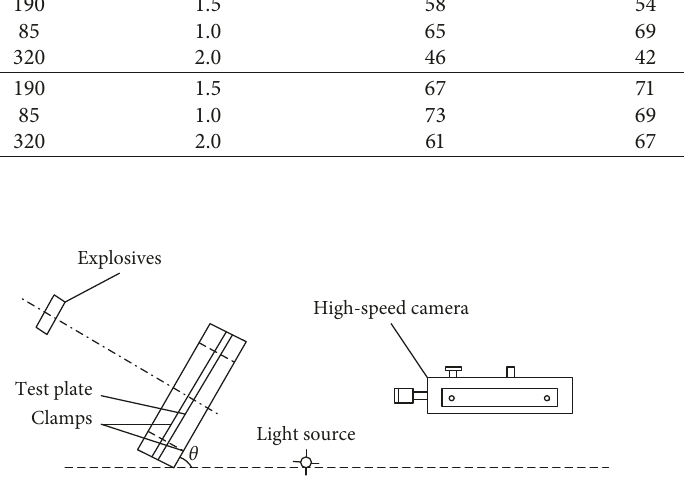
Figure 10: Experimental installation.